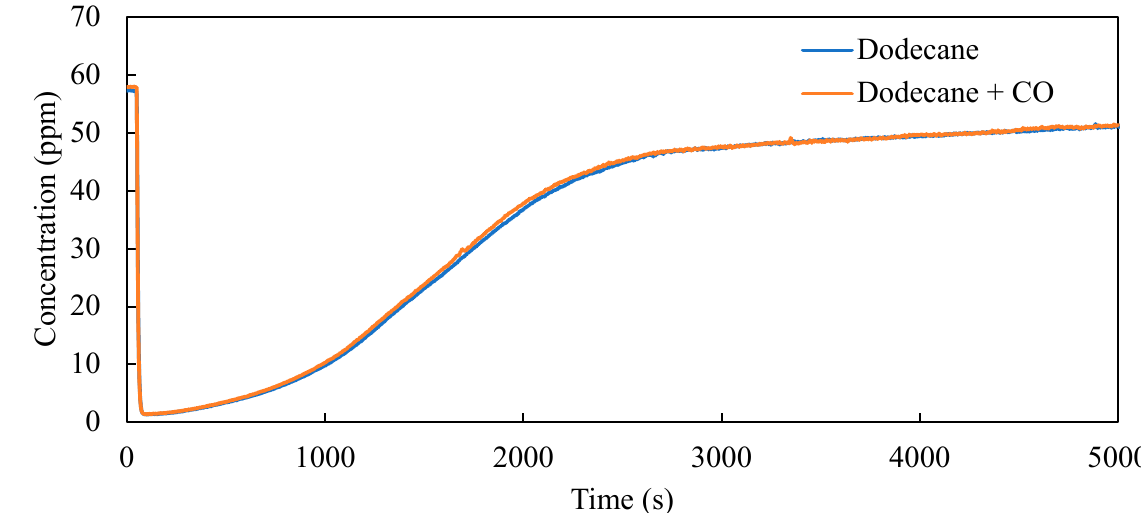
Figure 3. Dodecane uptake over 1% Pd/BEA with and without CO co-feed. (58 ppm C 12 H 26 , 0 or 500 ppm CO, 6% H 2 O, 12% O 2 , balance N 2 ).